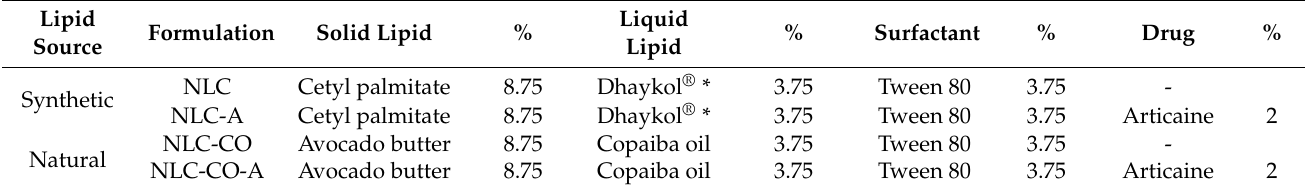
Table 1. Composition of optimized synthetic and natural NLC